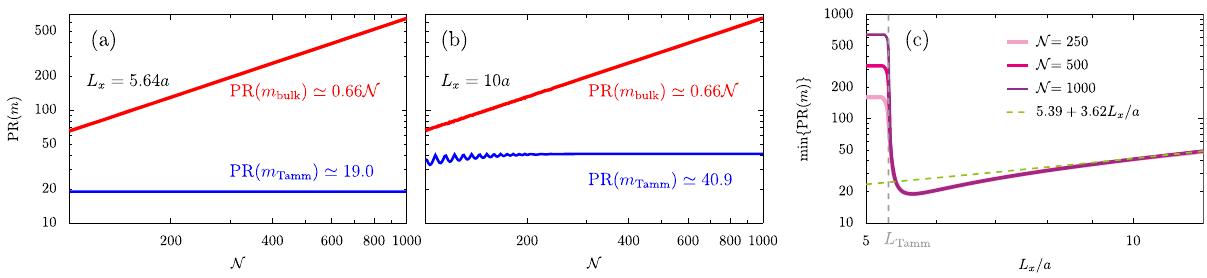
Figure 4: Panels (a) and (b): the participation ratio PR( m ) as a function of the number of dipoles N in the chain, where bulk (Tamm) states are denotedbythethickred(thinblue)lines(cf.Eq.(16)).Weshowresultsforthecavityheights L x =5.64 a (panel[a])and L x =10 a (panel[b]).Panel (c): the minimum of the participation ratio min{PR( m )} as a function of the reduced cavity height L x / a , calculated for N (cid:1) { 250 , 500 , 1000 } dipoles.Thelinear fi ttingvalidfor L x ≳ 8aisgivenbythedashedgreenline.Thecriticalcavitysize L Tamm isdenotedbytheverticaldashedgray line. In the fi gure, the interdipole separation d = 3 a , the dipole strength ω 0 c / a (cid:1) 1 / 10, and the cavity aspect ratio L y = 3 L x are